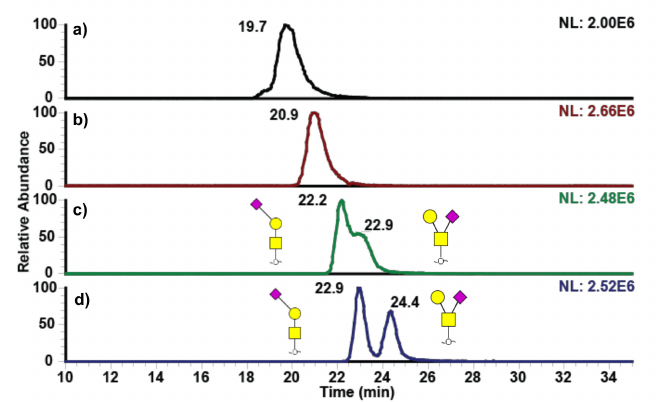
Figure 4. E ff ect of high temperature in separation of O-glycan. Panel ( a ) separation at 25 ◦ C, ( b ) separation at 45 ◦ C, ( c ) separation at 55 ◦ C, and ( d ) separation at 75 ◦ C.